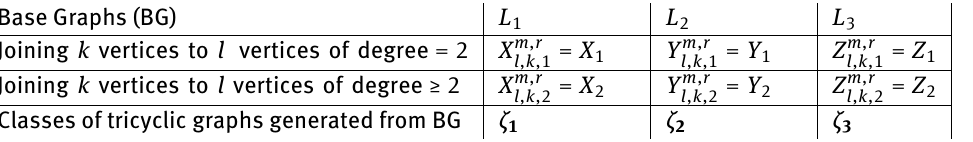
Table 6 Base Graphs (BG) H 1 H 2 H 3 Joining k vertices to l vertices of degree = 2 R m , r Joining k vertices to l vertices of degree ≥ 2 R m , r Classes of tricyclic graphs generated from BG ξ 1 ξ 2 ξ 3 Table 7 Base Graphs (BG) L 1 L 2 L 3 Joining k vertices to l vertices of degree = 2 X m , r Joining k vertices to l vertices of degree ≥ 2 X m , r Classes of tricyclic graphs generated from BG ζ 1 ζ 2 ζ